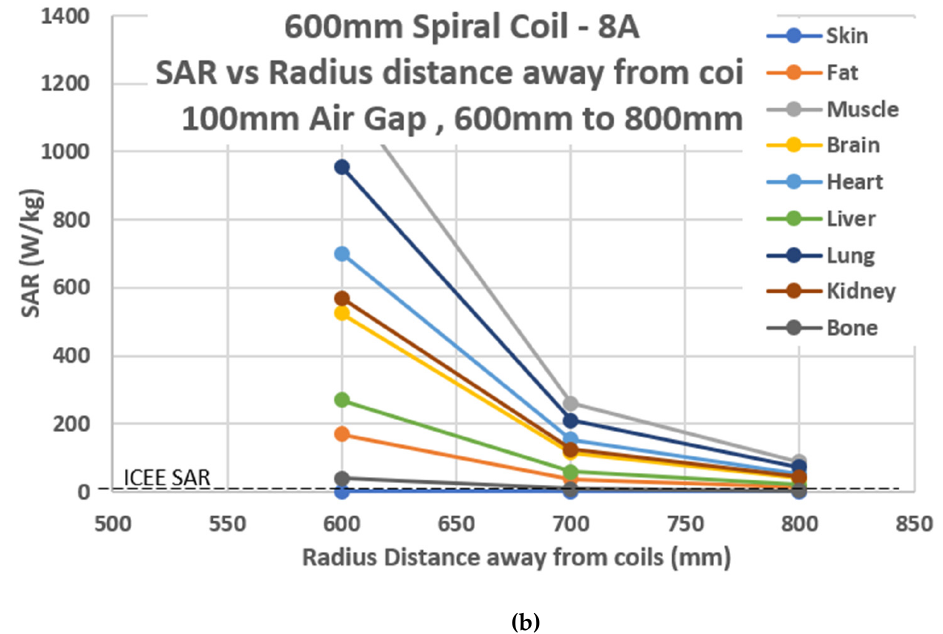
Figure 15. Specific Absorption Rates: ( a ) 120 mm spiral coil excited by 1 A current ( b ); 600 mm spiral coil excited by 8 A current.